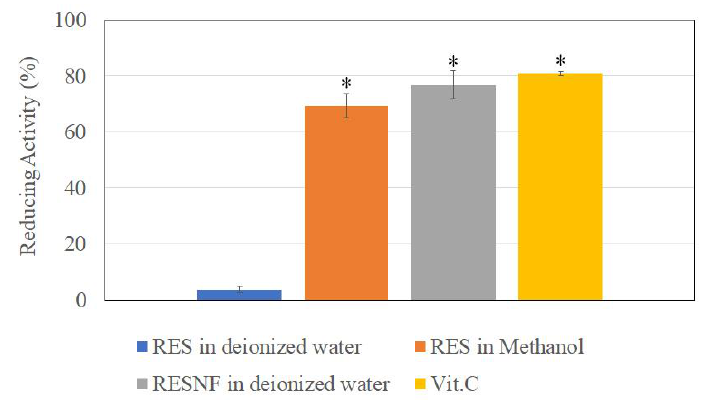
Figure 6. Reducing power of resveratrol in deionized water, resveratrol in methanol, resveratrol nanofibers (RESNF) in deionized water, and vitamin C at 20 µ g / mL concentration. Results are shown as mean ± SEM of three independent experiments. * represents P < 0.05 when compared to resveratrol in deionized water.